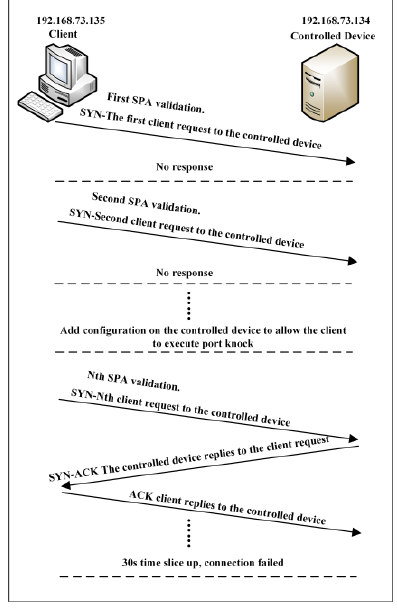
Figure 12. SPA authentication rules.